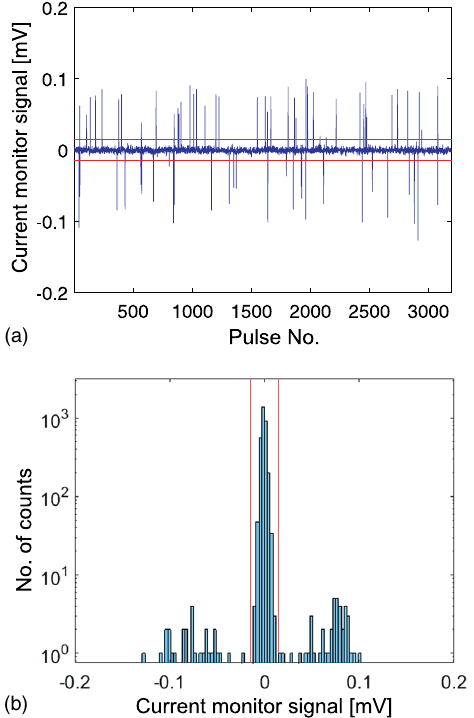
FIG. 18. Current monitor signal recorded by placing the electron beam in the central axis of the copper structure (a) and histogram of the distribution of the current monitor voltages (b), with 1.3 mm gap, 3.2 nC of bunch charge, and σ